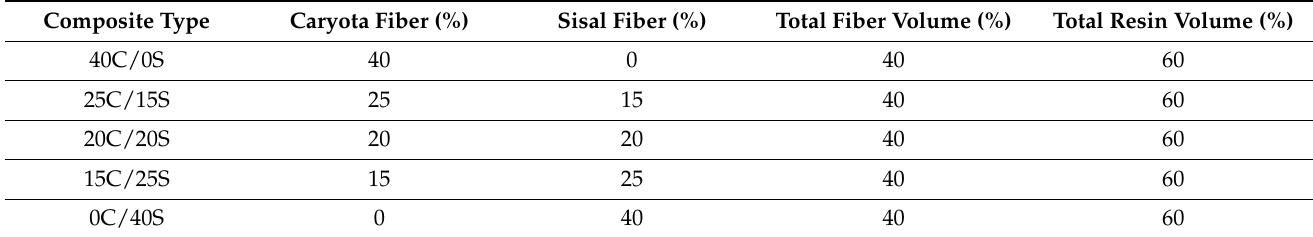
Table 2. Fiber weight fractions.